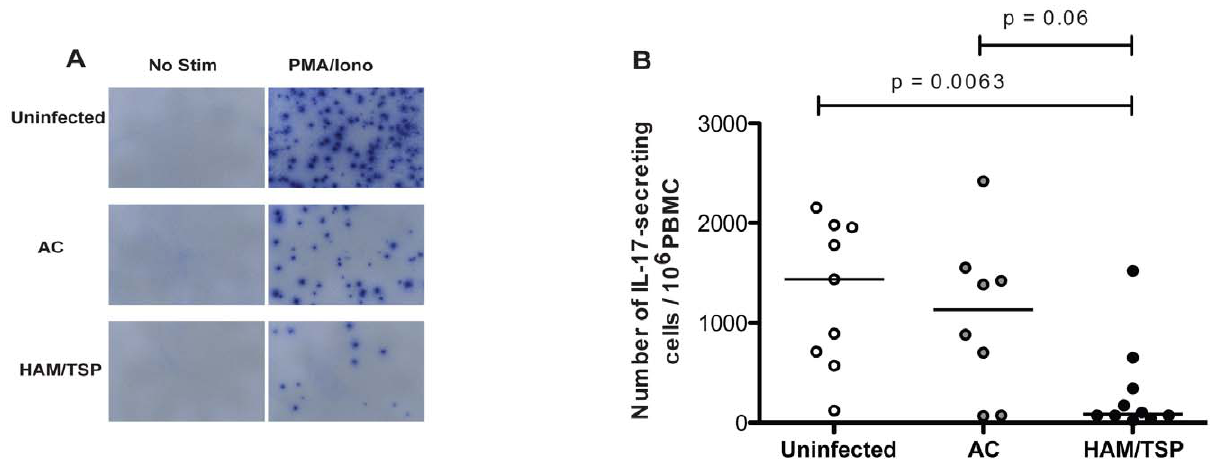
Figure 4. Measurement of IL-17 secretion of PBMC by ELISPOT. Experiments run in duplicate. Results are medium-subtracted and normalized to 10 6 cells. The statistical difference was deemed significant using a Mann-Whitney U test analysis if p , 0.05. Horizontal bars indicate median values. (A) ELISPOT data from 1 representative experiment of each group of subjects. (B) Number of IL-17 secreting cells in PBMC from 9 uninfected donors, 8 HTLV-1 asymptomatic carriers and 10 HAM/TSP